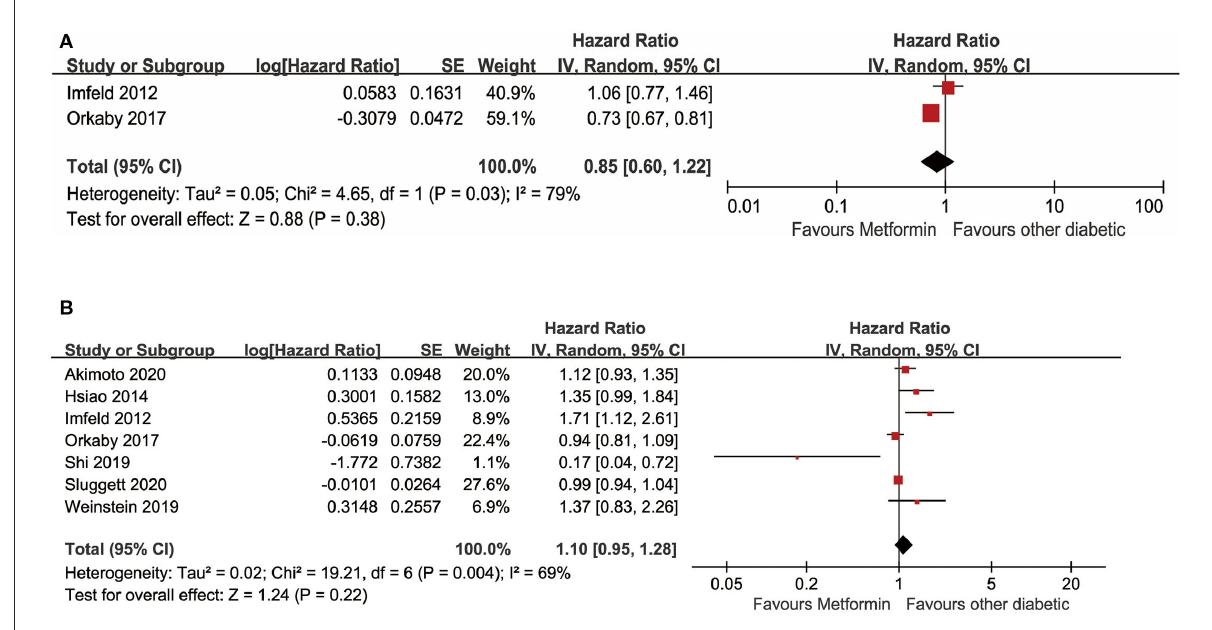
FIGURE4 (A) Meta-analysis of unadjusted covariates between metformin and the occurrence of Alzheimer’ s disease. (B) Meta-analysis of adjusted covariates between metformin and the occurrence of Alzheimer’ s